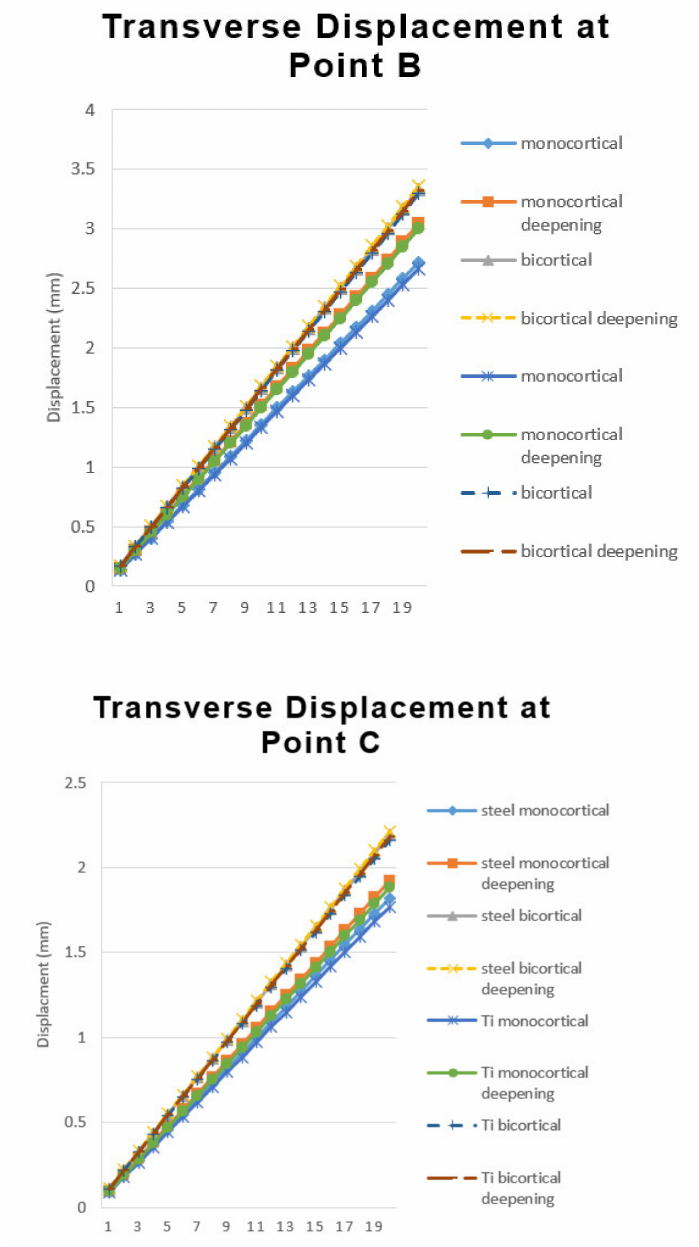
Figure 7. ( A – C ) Transverse displacement was recorded and evaluated in the three landmarks, points A, B, and C. The total transverse displacement at step 20 was measured at levels A and B, located at the coronal plane, and at levels B and C, located at the axial